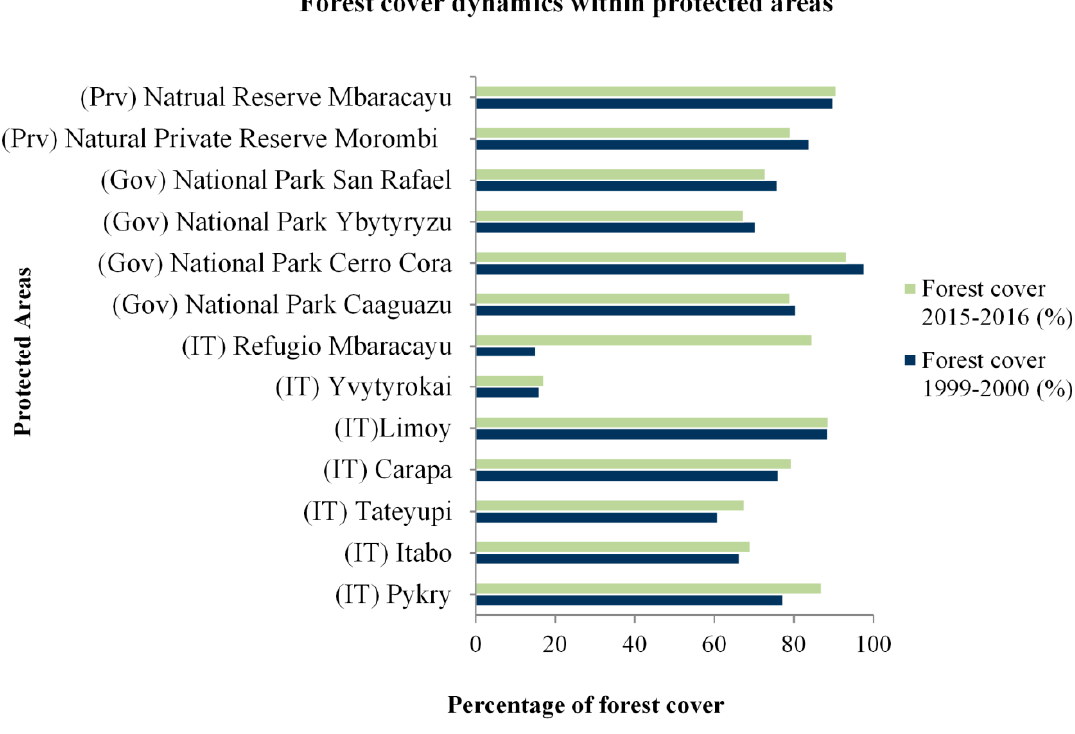
Figure 4. Comparison of forest dynamics between protected areas based on the type of ownership: Prv. (Private ownership), Gov. (Governmental ownership) and IT (Owned by the ITAIPU hydroelectric dam).